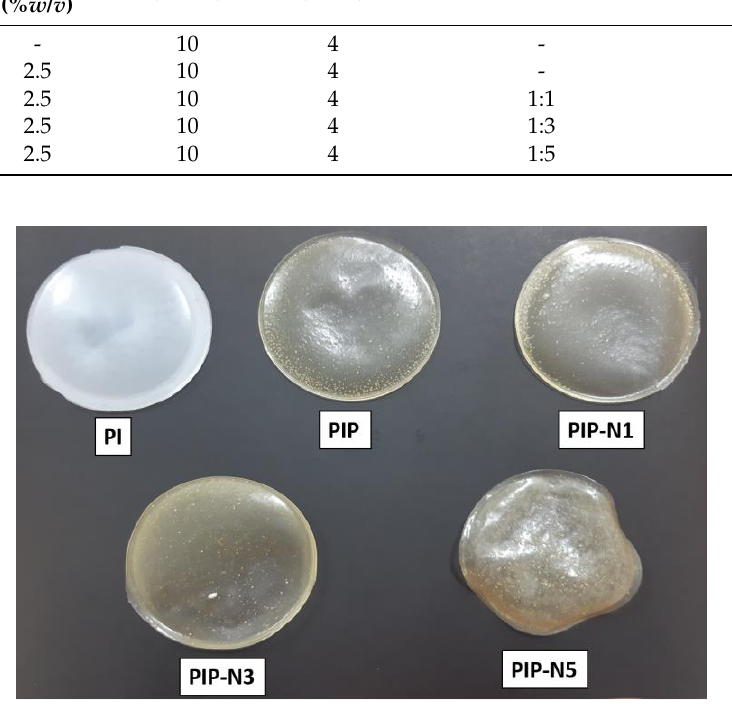
Figure 2. Digital images of the film samples.